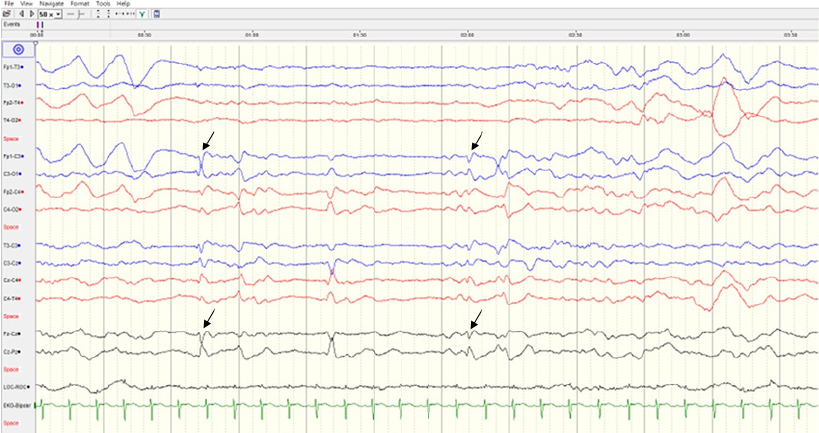
Figure 4. Sleep EEG of Case 2. It showed bilateral focal discharges (arrows) from central and temporal regions.